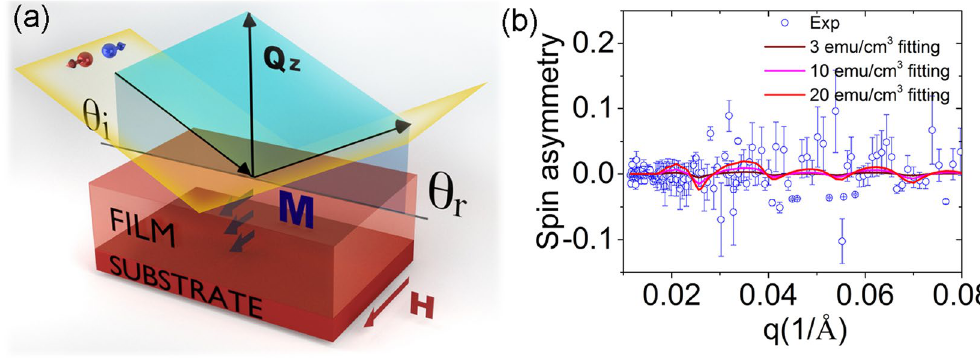
Figure 4. ( a ) A Scheme of PNR measurement. ( b ) The spin asymmetry of PO 2 = 10 − 3 sample fitted with three different magnetization